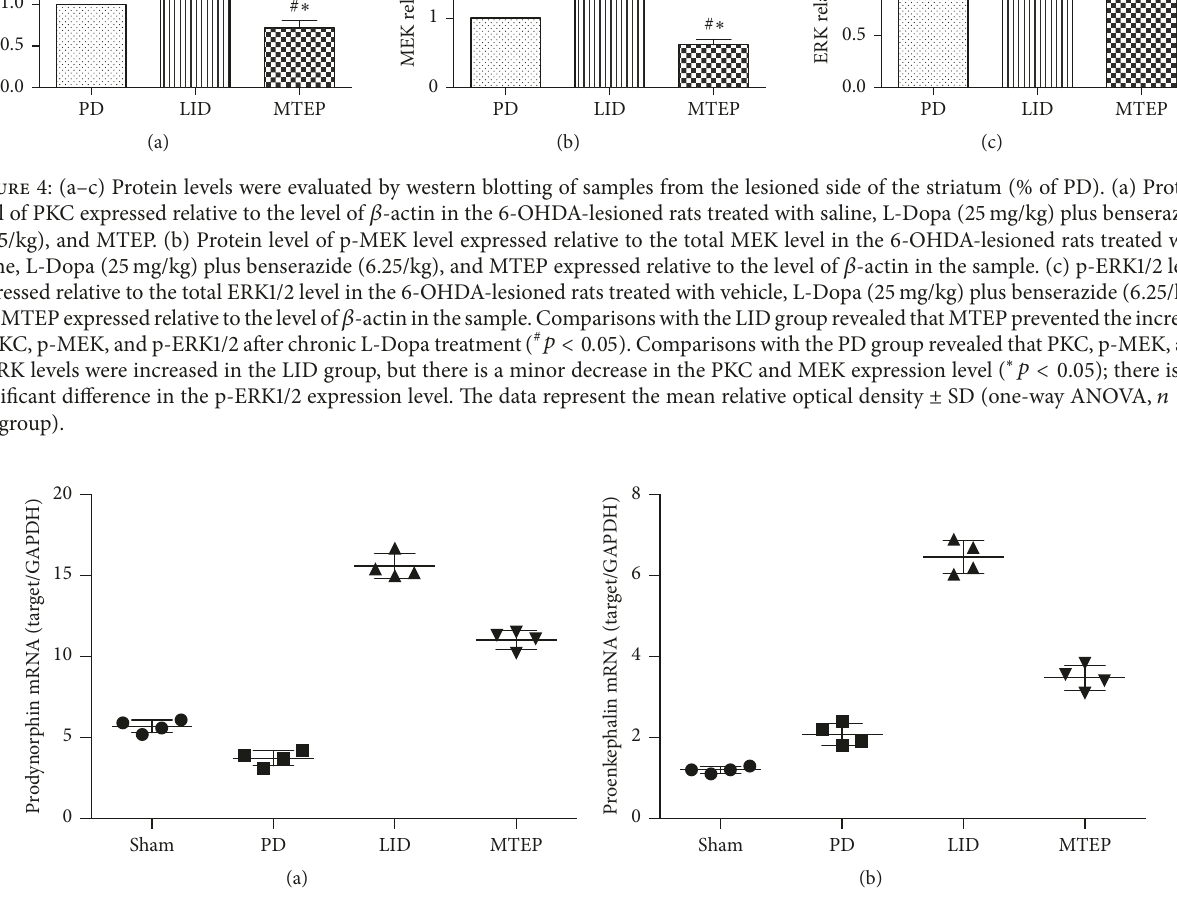
Figure 5: mRNA level of prodynorphin (a) and proenkephalin (b). MTEP reduced prodynorphin and proenkephalin mRNA levels in the striatum of dyskinetic rats. Striatal prodynorphin and proenkephalin mRNA expression levels were determined by real-time PCR. Increased levels of the two genes were found in LID rats. There is a minor but significant ( 𝑝 < 0.05 ) drop in the prodynorphin in the PD group. The antagonist of mGluR5 decreased the mRNA expression level in both prodynorphin and proenkephalin (one-way ANOVA, 𝑛 = 4 per